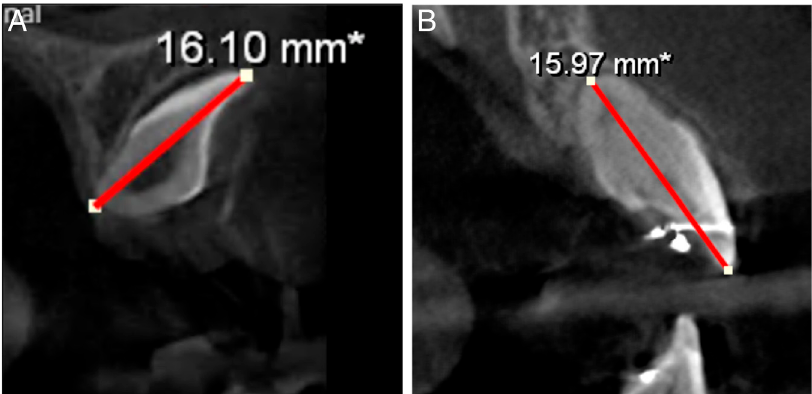
Figure 12. Root length of the dilacerated impacted tooth 11 on the cone-beam computed tomography (CBCT). (A) Pre-op root length was 16.10mm; (B) Post-op 11 root length was 15.97 mm.